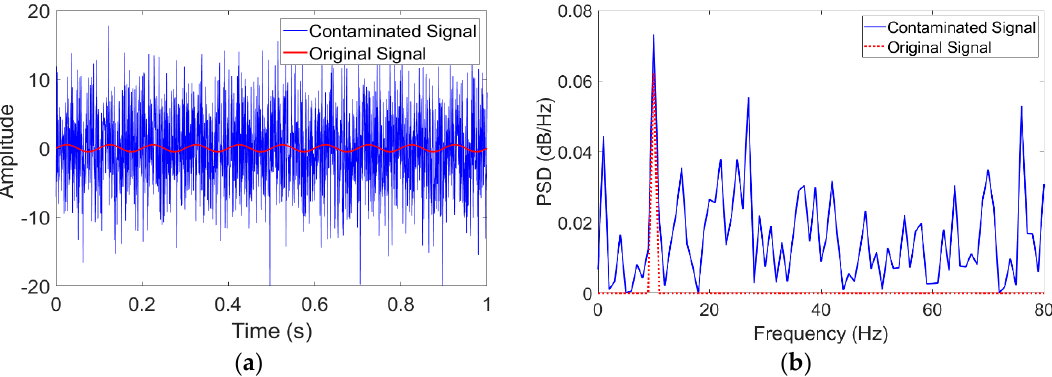
Figure 4. The raw and contaminated signals and their spectra. ( a ) Signals record; ( b ) Signals PSD.